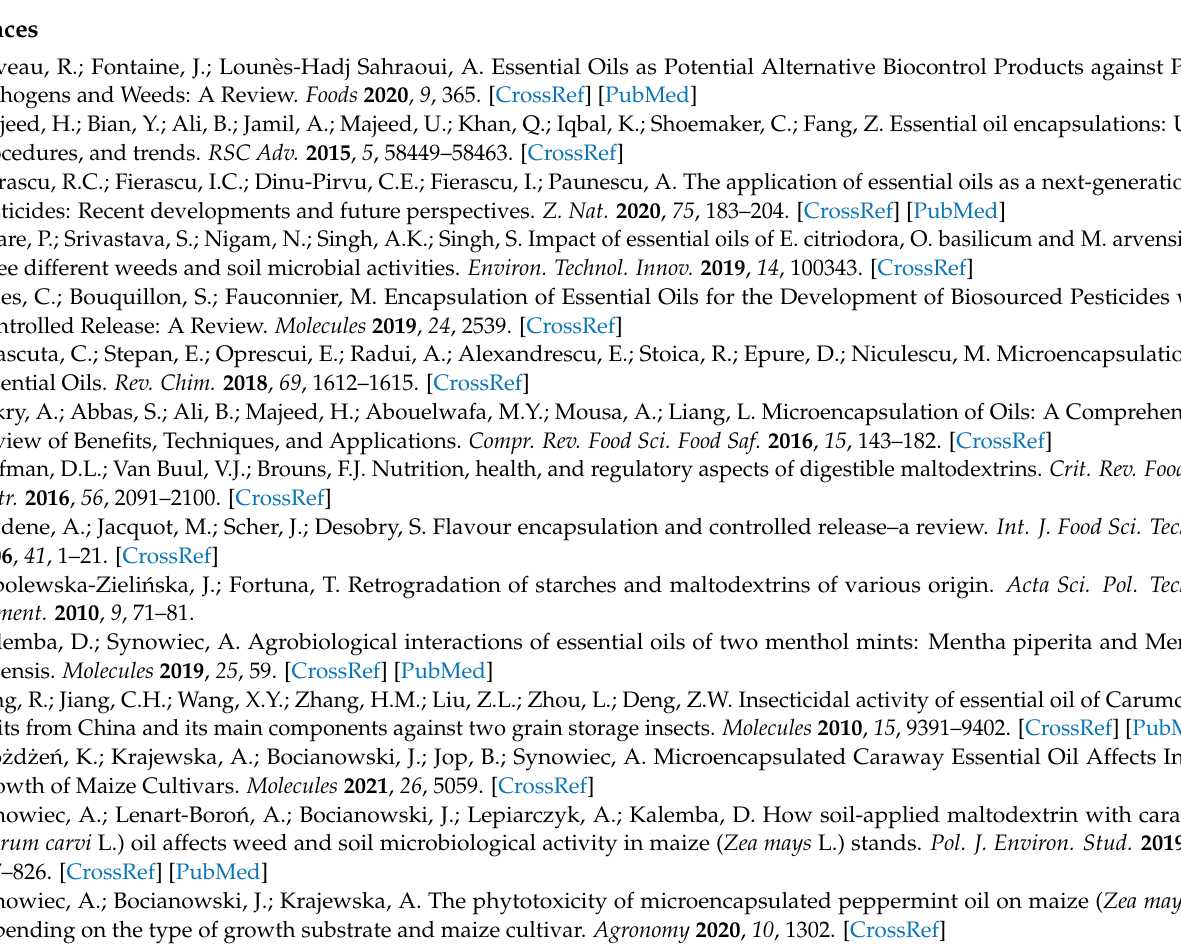
Table S3: Mean values [in millions], standard deviations and Fisher’s least significant differences (LSDs) for